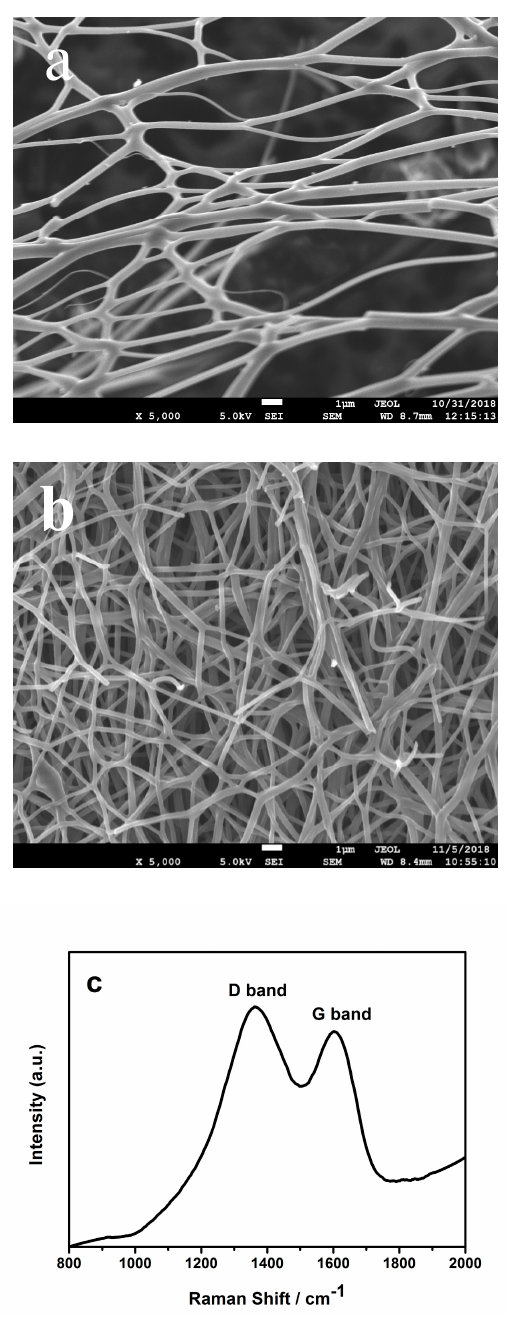
Figure 1. SEM images of carbon nanofibers (CNFs) ( a ) and 3D-CNFs ( b ) and Raman spectra of 3D-CNFs ( c